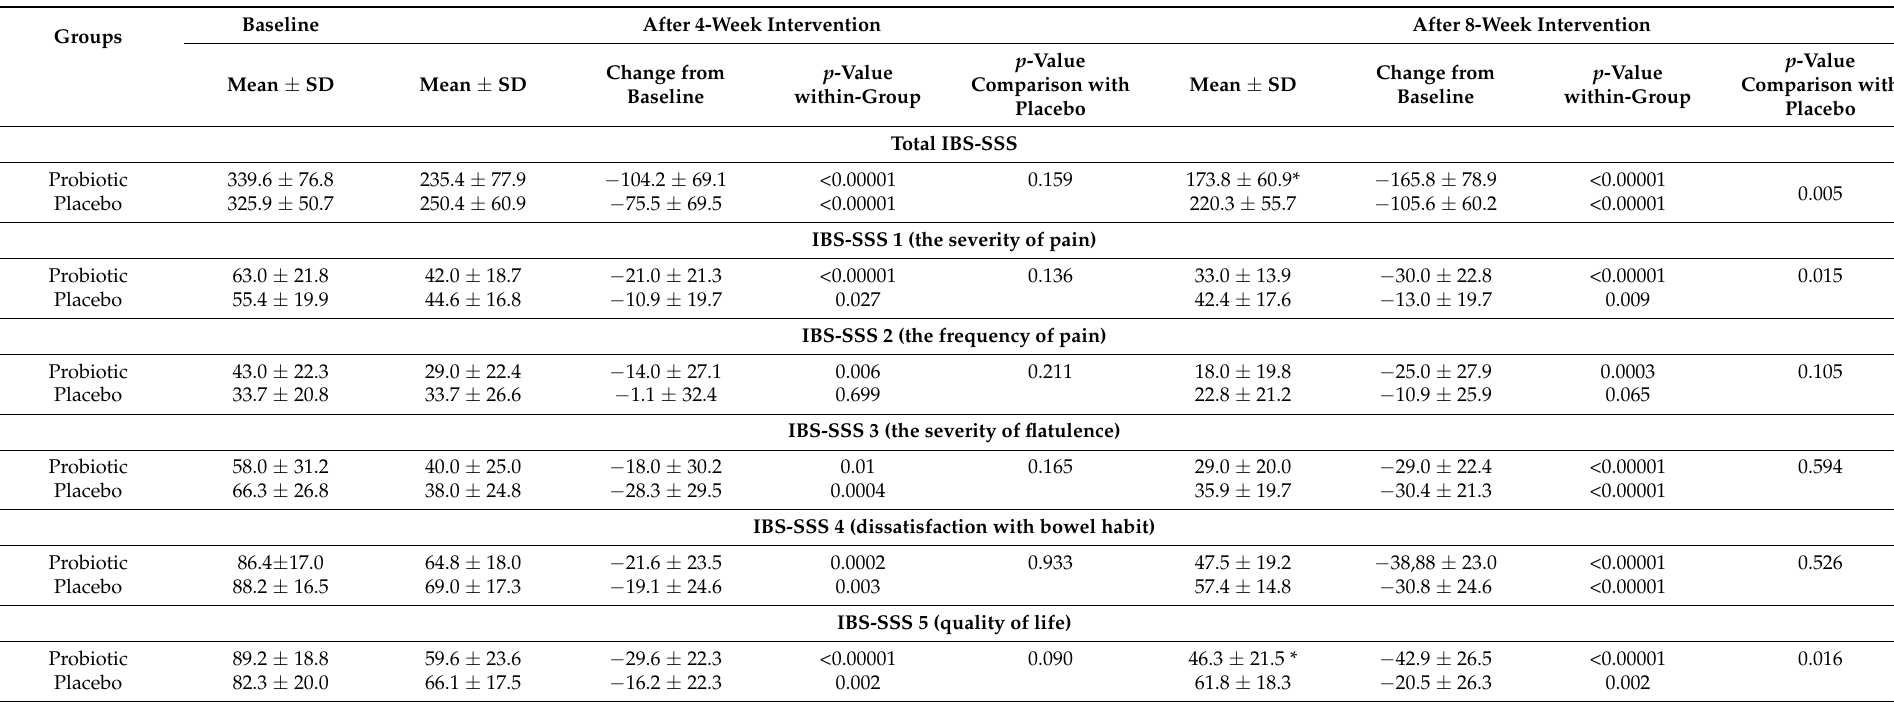
Table 4. The impact of probiotic intervention on changes in IBS-SSS